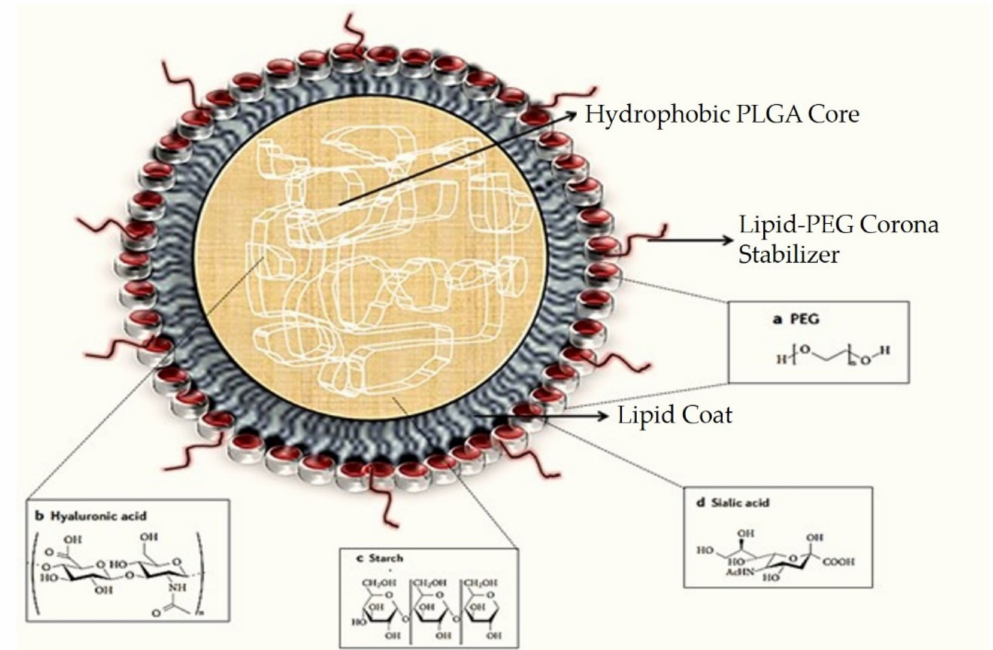
Figure 3. A typical polymeric lipid hybrid nanoparticle (PLN) is depicted in the above representation. These PLNs are made up of a PLGA (polylactic-co-glycolic acid) core, which is hydrophobic in nature, hydrophilic polymer coatings, and a lipid monolayer at the interface between the